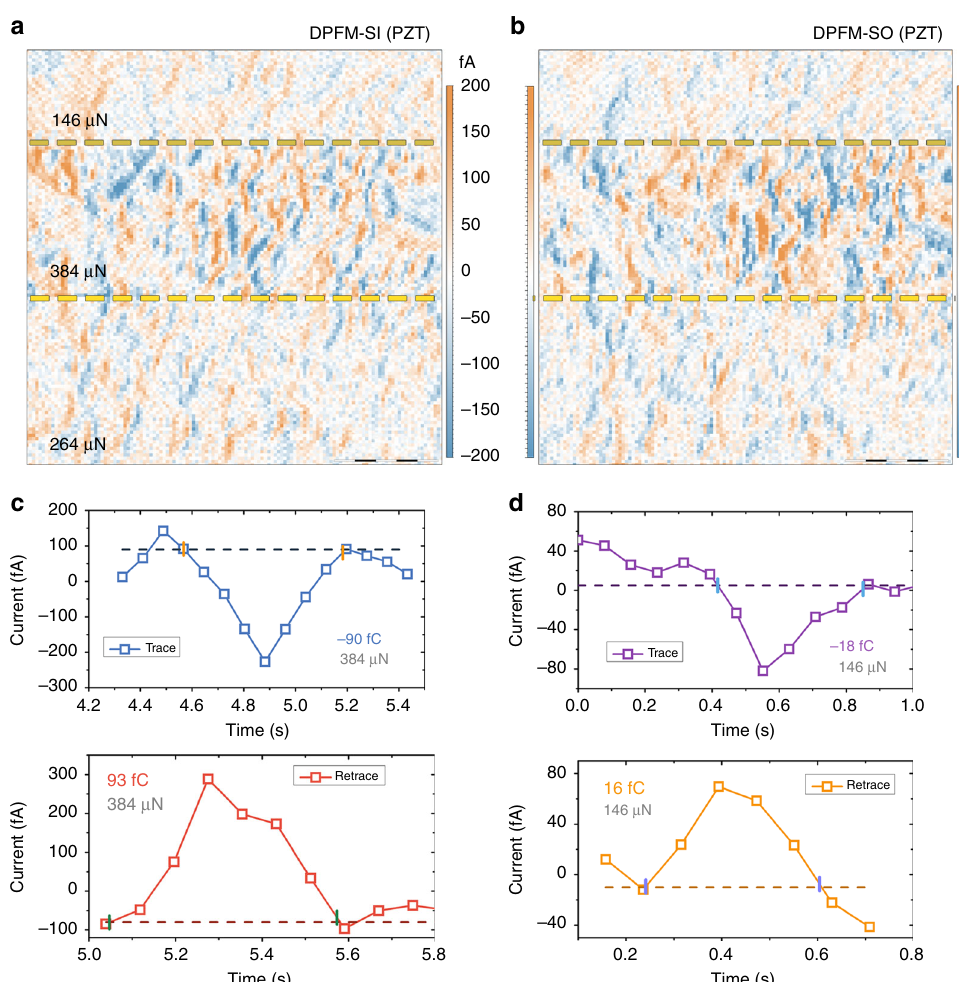
Fig. 6 Piezogenerated charge of lead zirconate titanate (PZT) a , DPFM-SI and b , DPFM-SO of a PZT sample with natural domains, scale bar 2.5 μ m. The force applied was increased at the middle of the scan, and then further decreased to see the current dependence upon the force applied. PZT was selected as it has a small surface charge density compared with BFO and PPLN but a higher d 33 constant. c and d are corresponding current pro fi les extracted from a and b . The d 33 constant, calculated by dividing the collected charge by the applied force is in agreement with values reported in the literature, and that the current recorded is larger compared with experiments performed on BFO and